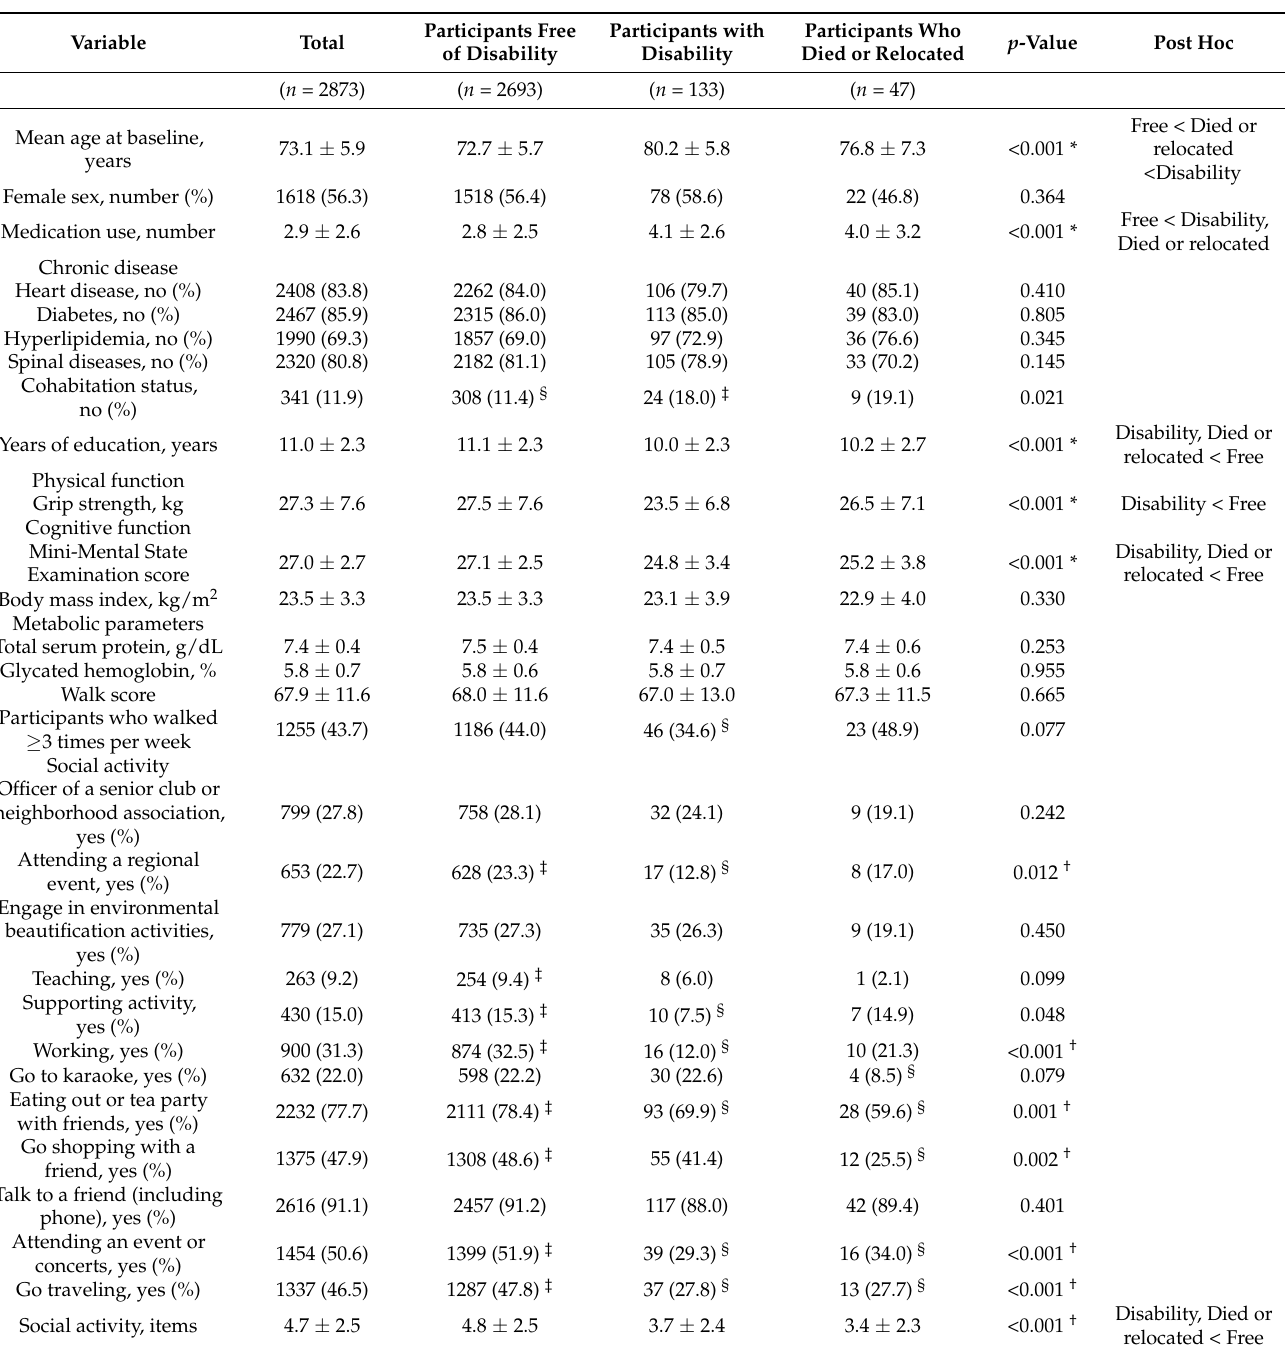
Table 1. Baseline characteristics of the study participants by follow-up